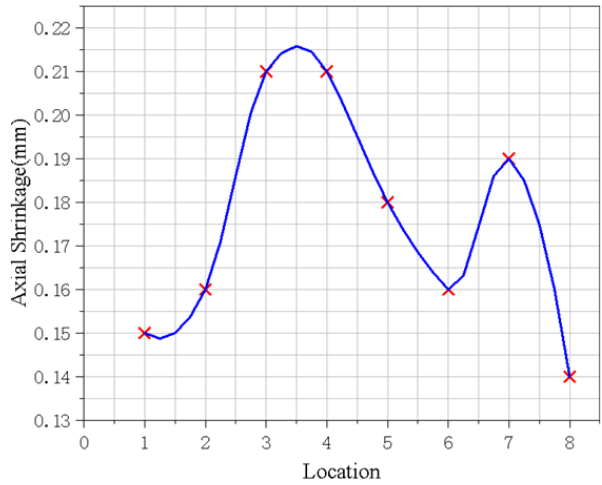
Figure 12. Axial shrinkage of experimental workpiece after